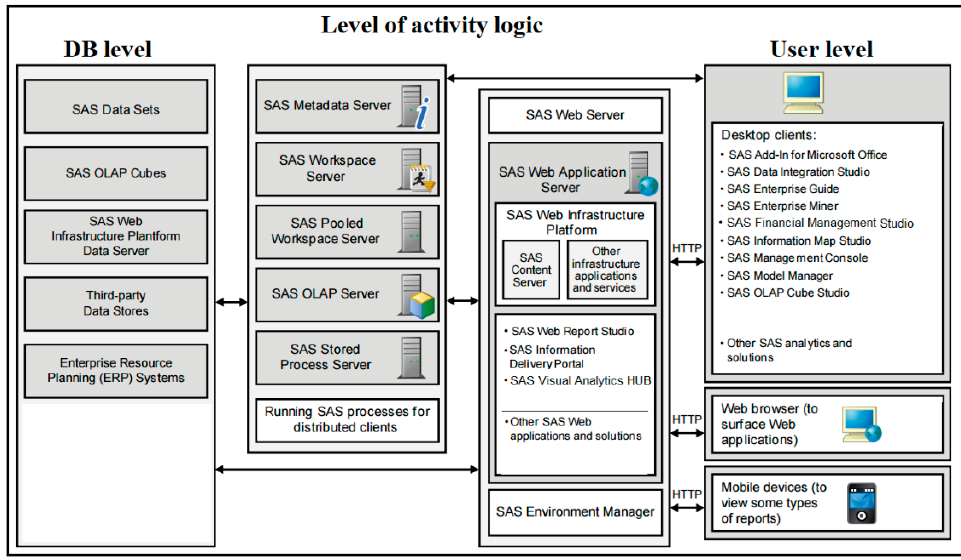
Figure 7. SAS Intelligence Platform Multilevel Architecture.